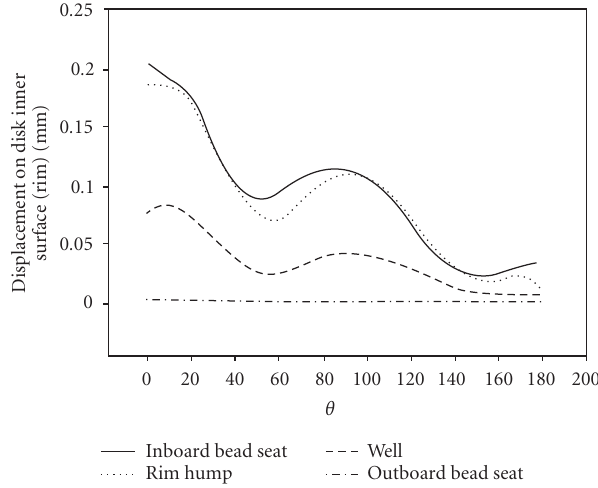
Figure 14: Variation of displacement of the aluminum alloy rim, with circumferential angle, for an inflation pressure of 0 kPa.